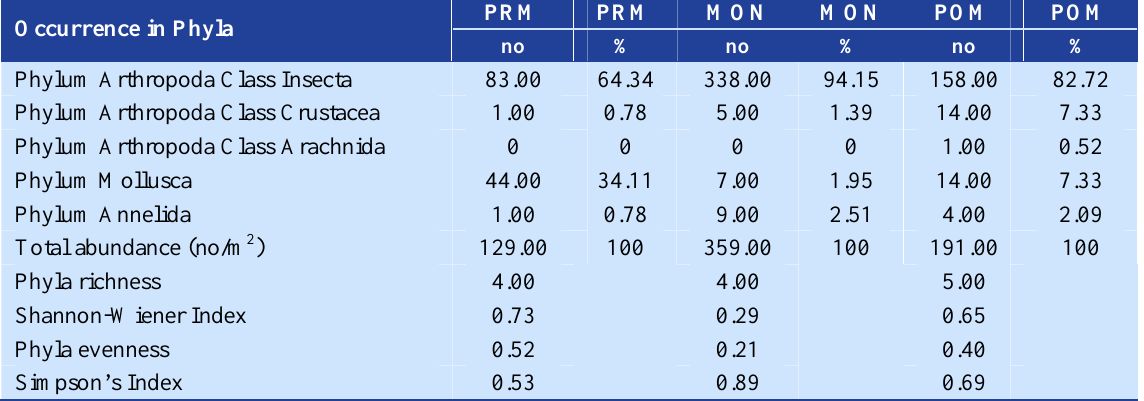
Table 2. Seasonal phyla compositions and diversity indices of macroinvertebrates Occurrence in Phyla